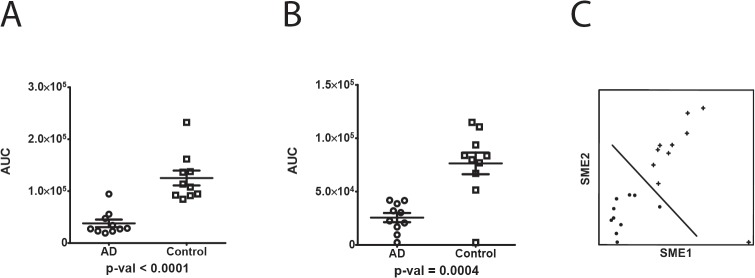
Quantitation of SME1 and SME2 by dMS (Cohort-1) and 2-way plot.SME 1 (Peptide NSEPQDEGELFQGVDPR, from neurosecretory protein VGF precursor) and SME2 (peptide VAELEHGSSAYSPPDAFK, from neuronal pentraxin receptor-1) are significantly reduced in AD patients as compared to controls. Area under the curve (AUC) intensity measurements are shown on linear scale. Horizontal bar represents the mean value, vertical error bar represents SD. (A) SME1, P < 0.0001. (B) SME2, P < 0.0005. (C) Two way plot of SME1 and SME2. The symbols (●, +) represent AD and control, respectively.